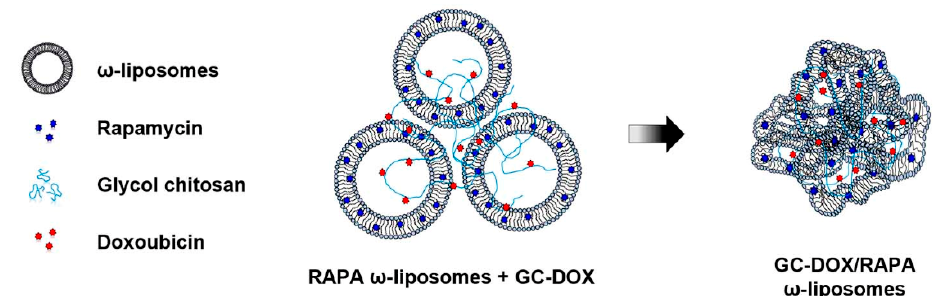
Figure 10. Schematic illustration of liposome containing doxorubicin and rapamycin and complexed with glycol chitosan. The nanovectors are stable at pH 7.4 and aggregate when the pH is lowered to 5.0. Reproduced under Creative Common license from ref [121] .